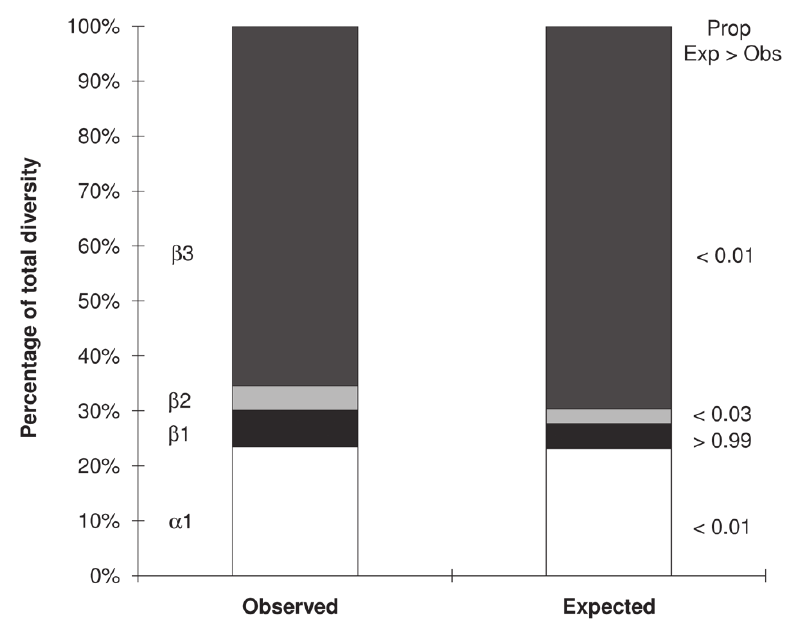
Figure 2 - Additive partitioning of diversity of amphibians recorded in Brazil in three spatial scales. The values on the right refer to the proportion in which the number of times the value expected by the null model (Exp) was higher than that value observed (Obs). The percentage values correspond to the proportion of the number of species recorded in each spatial level, being α1 and β1 the alpha and beta diversity in the lowest level (i.e., states), and β2 and β3, the beta diversity in the two subsequent levels (i.e., geographical regions and